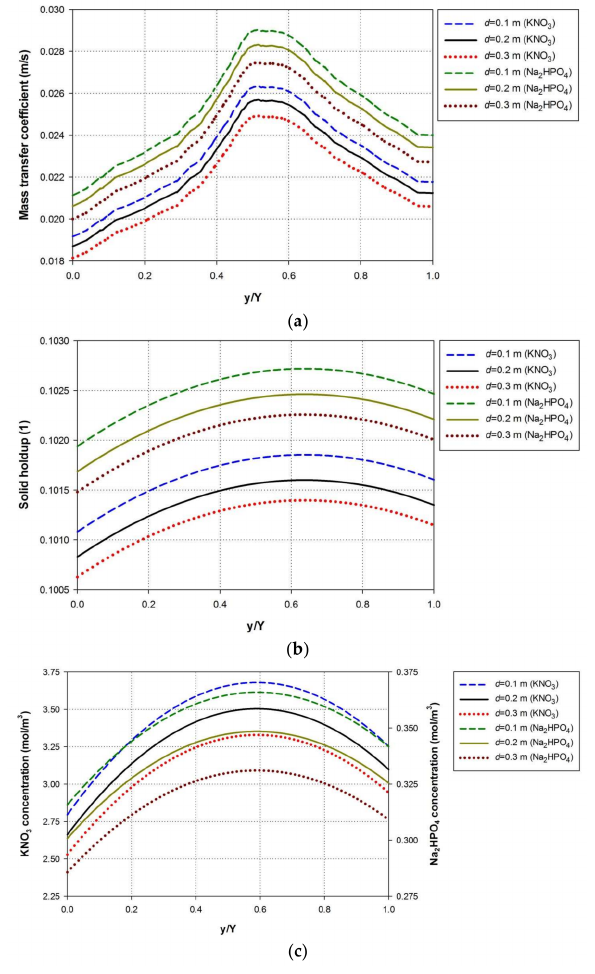
Figure 7. Effects of water depths on ( a ) mass transfer coefficient; ( b ) solid holdup; and ( c ) nutrient concentrations in a raceway pond with AR = 10 and paddle wheel speed =